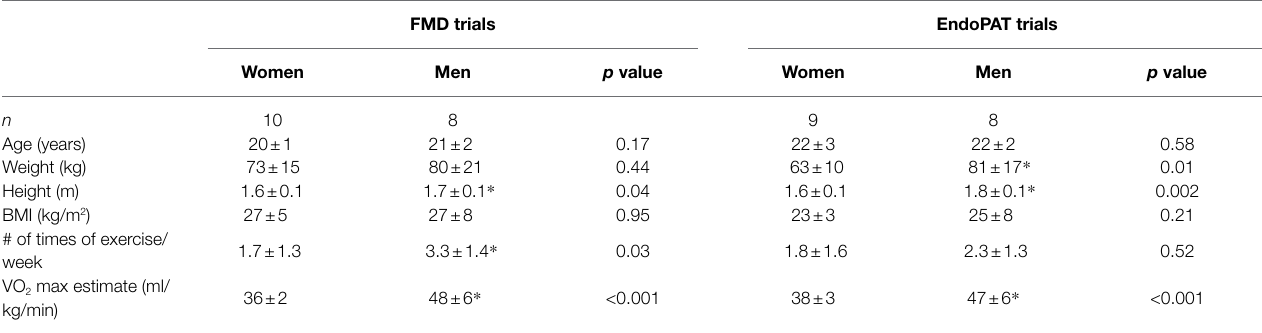
TABLE 1 | Anthropometrics of women and men who completed FMD or EndoPAT testing.